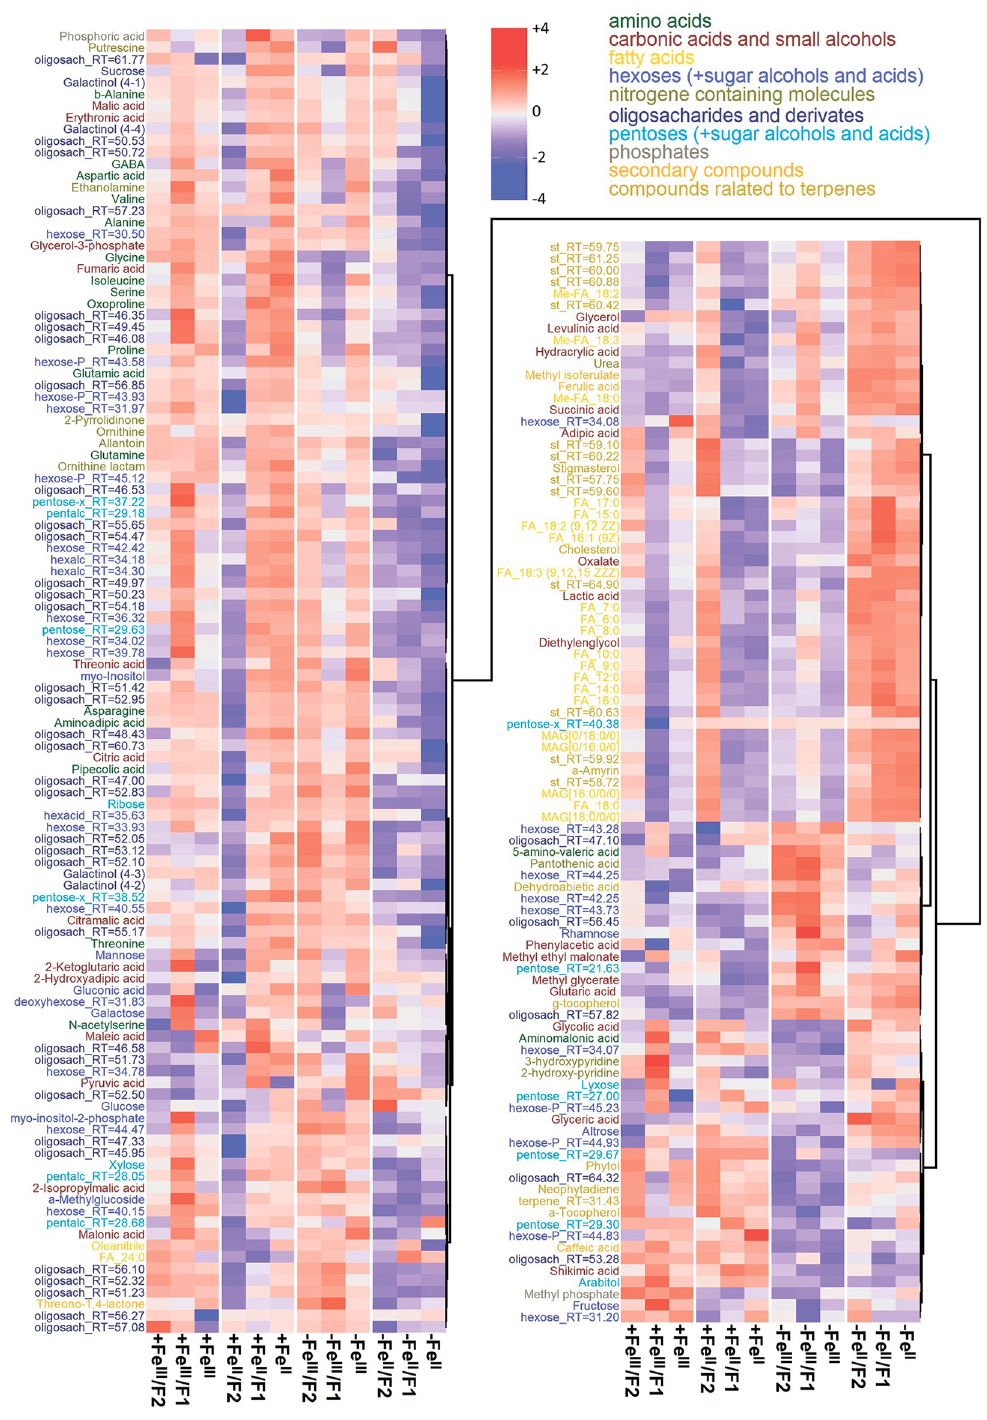
Fig 1. Heat map of average arbitrary content of identified (at least up to class) metabolites in the cucumber leaves grown hydroponically in a nutrient solution, either with (+Fe II and +Fe III ) or in Fe-free ( − Fe II and − Fe III ) nutrient solution, with or without the supply of 0 (F0), 1 (F1) and 2 (F2) mg L -1 fullerenol for 10 days. Data are normalised to the median of observation, log-transformed and standardised. The map is combined with the dendrogram of hierarchical clustering using the Spearman distance (1 − r), clusters are agglomerated according to the Ward method. Keys: “+”— presence, “-”—absence, “F”—fullerenol in media, “F1”—1 mg L -1 , “F2”—2 mg L - 1 , in metabolite names: “RT”—retention